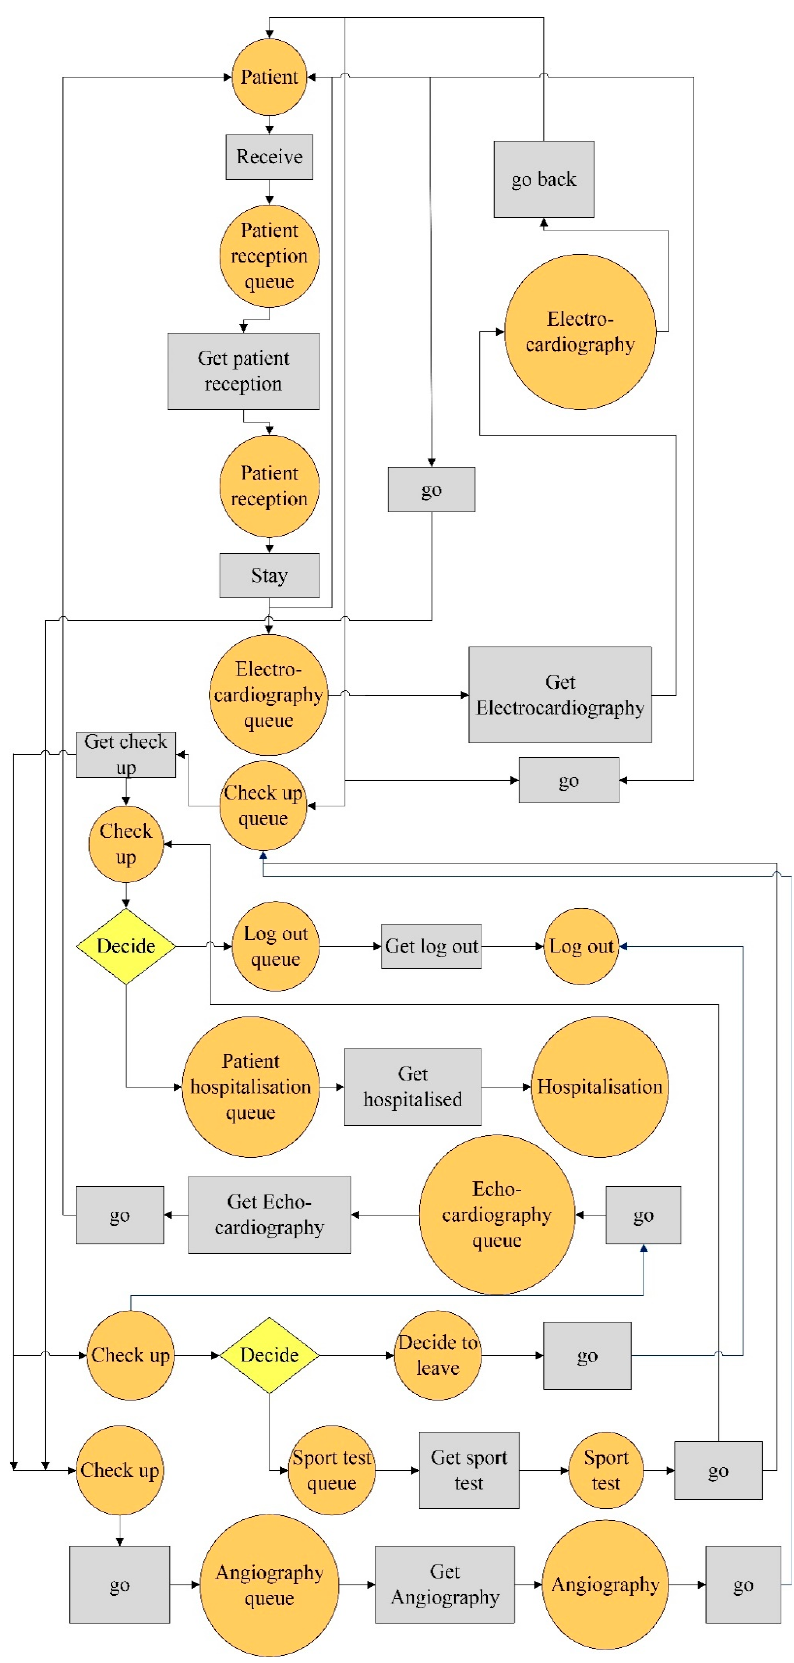
Figure 5. The sequence diagram of the heart clinic.